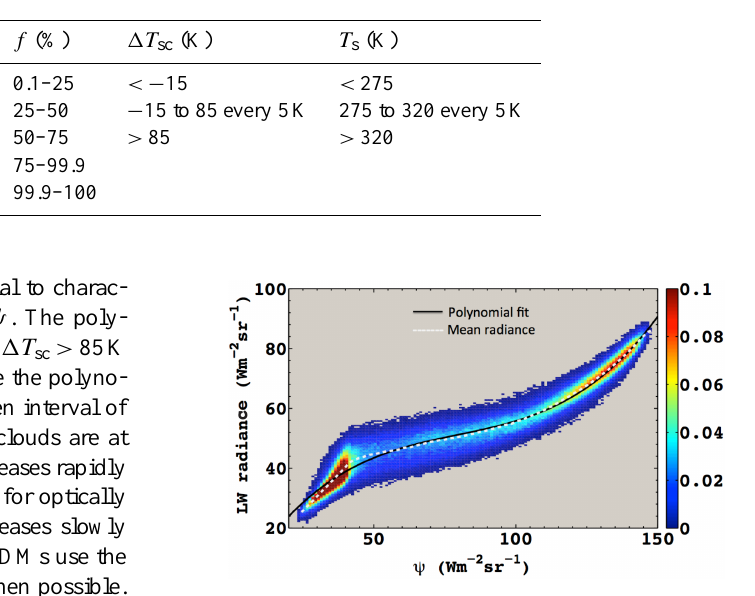
Table 5. Surface type, precipitable water ( w ), cloud fraction ( f ), surface–cloud temperature difference ( (cid:49)T sc ), and surface skin tempera- ture ( T s ) intervals used to determine LW and WN ADMs under cloudy conditions over the ocean, land, and desert surface. There are 4 w bins, 5 f bins, 22 (cid:49)T sc bins, and 11 T s bins.